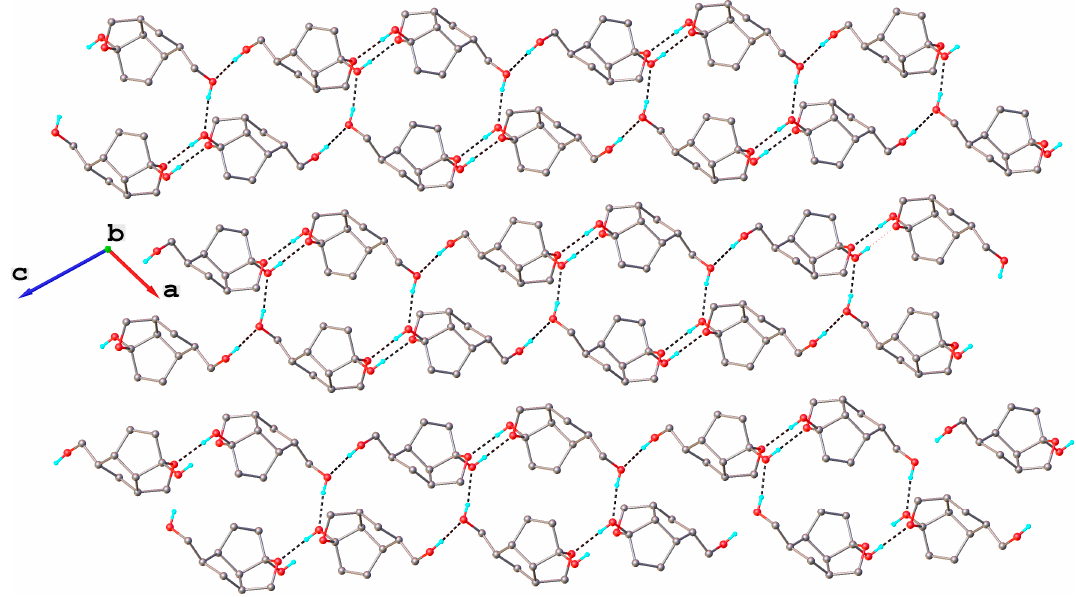
Figure 7. A fragment of the crystal structure of compound 15 viewed along the b crystallographic axis. Table 3. H-bond parameters.